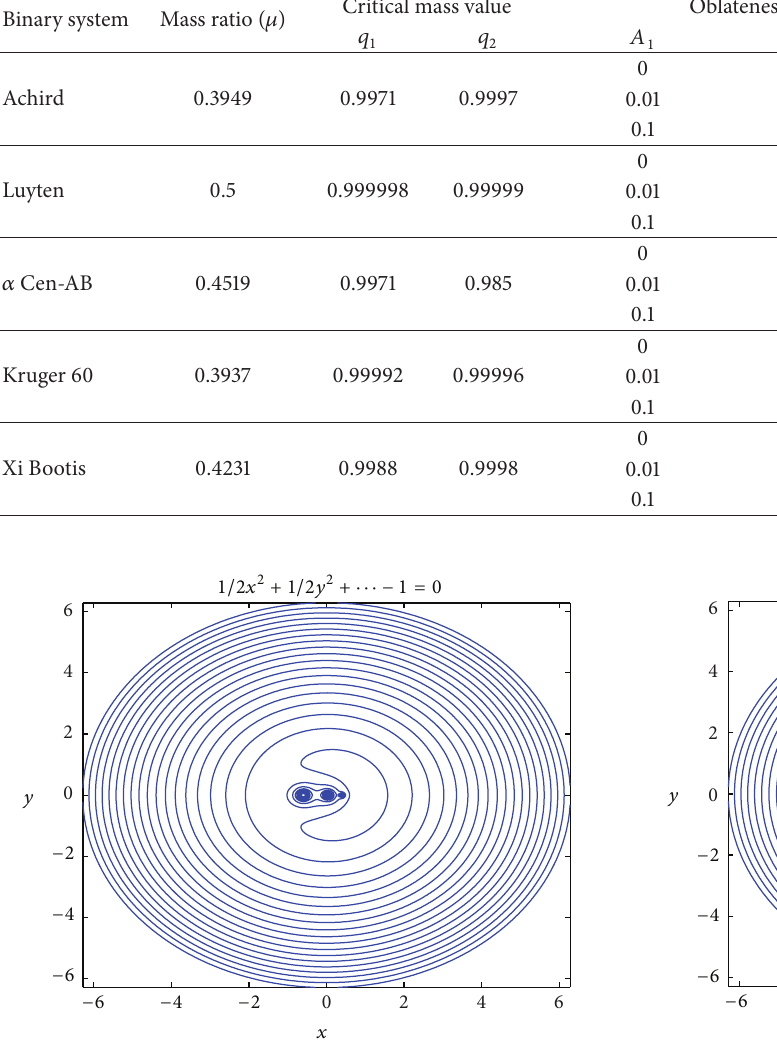
Figure 10: Curve of zero velocity (Luyten-2) 𝑞 1 = 0.999998 , 𝑞 2 = = 0.01 , 𝐴 = 0.02 0.99999 , and 𝐴 1 2